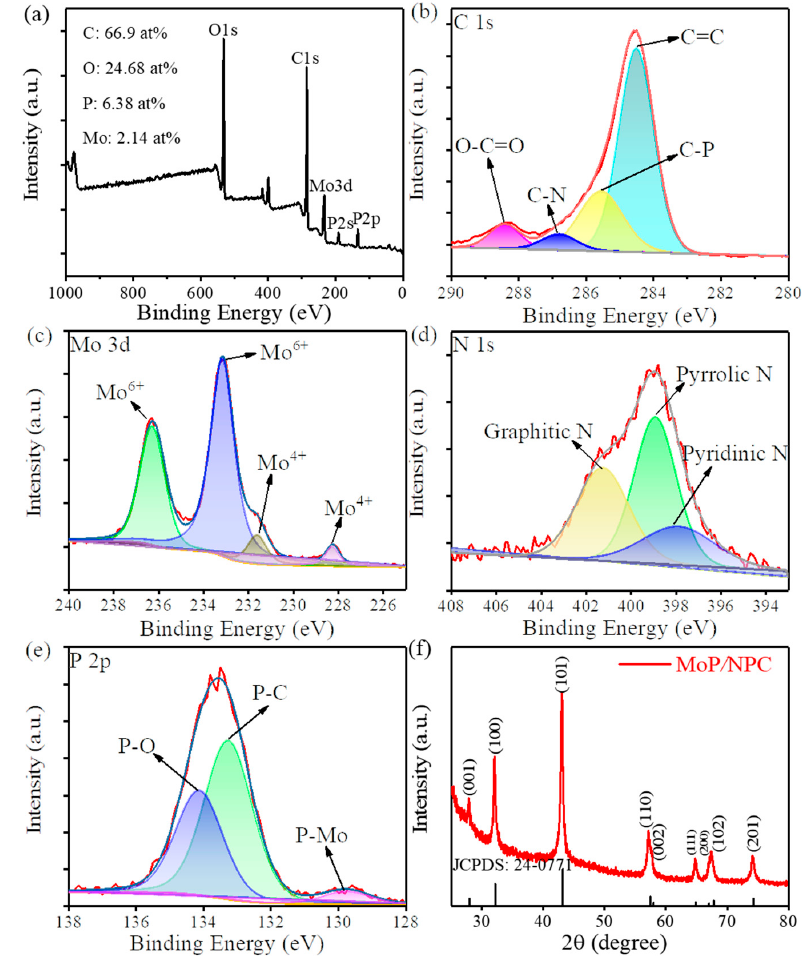
Figure 2. MoP/NPC: ( a ) XPS survey spectrum; ( b ) high-resolution XPS spectra of C 1s; ( c ) Mo 3d; ( d ) N 1s; ( e ) P 2p; and ( f ) XRD